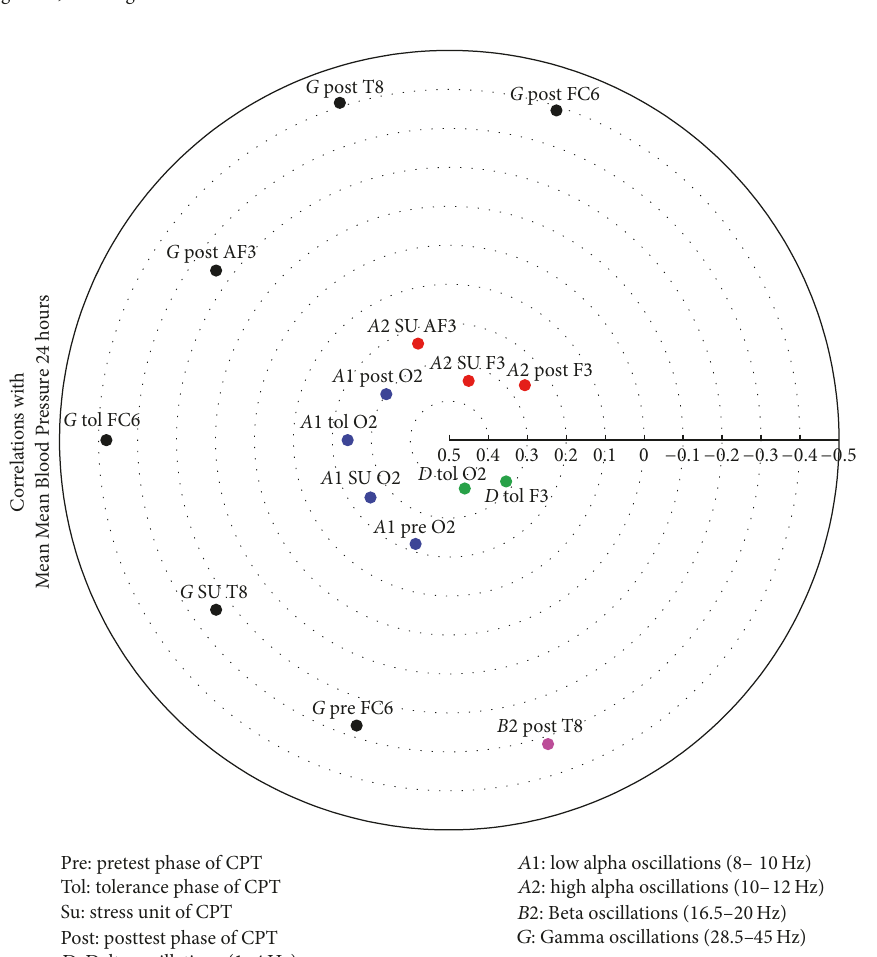
Figure 8: Heliograph of the correlations between Mean Mean Blood Pressure 24 hours and the statistically significant different CPT-induced EEG oscillations depicted by concentric circles in the ( − 1)-(0)-(+1)